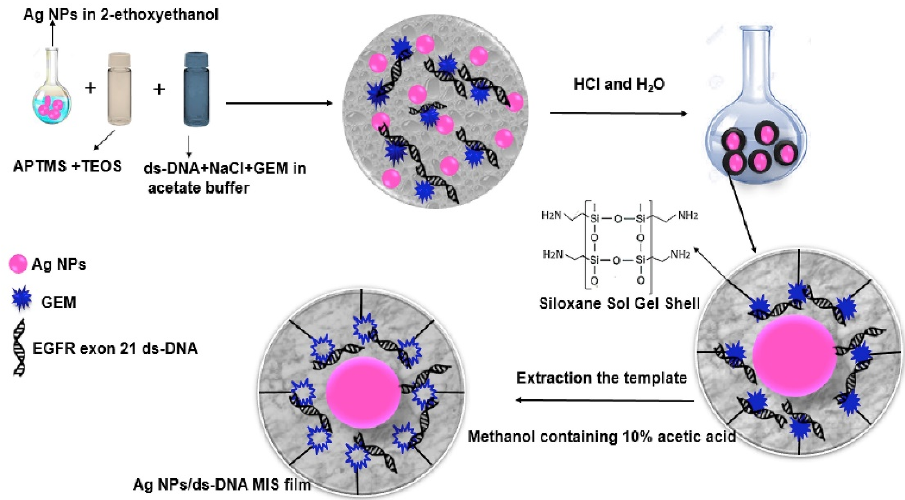
Figure 4. Synthetic steps of molecularly bio-imprinted siloxane biosensor on the basis of core–shell silver nanoparticles/EGFR exon 21 L858R point mutant gene/siloxane film. Reprint from Elsevier [219].